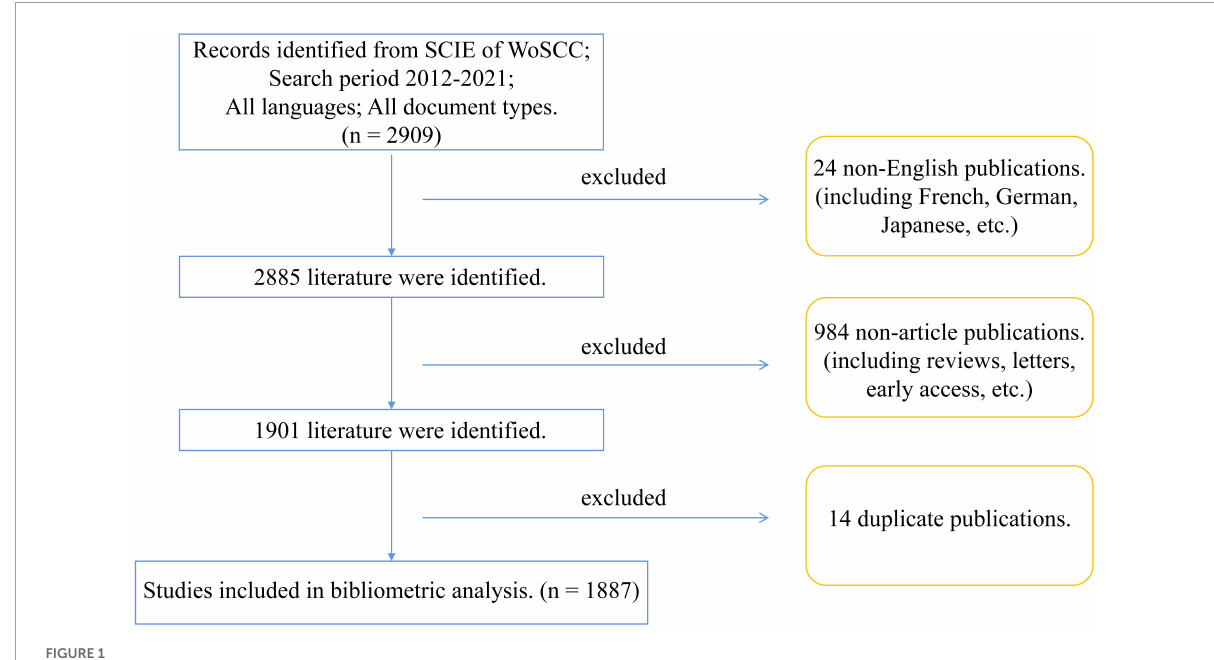
FIGURE1 Flow chart of the data identification and screening